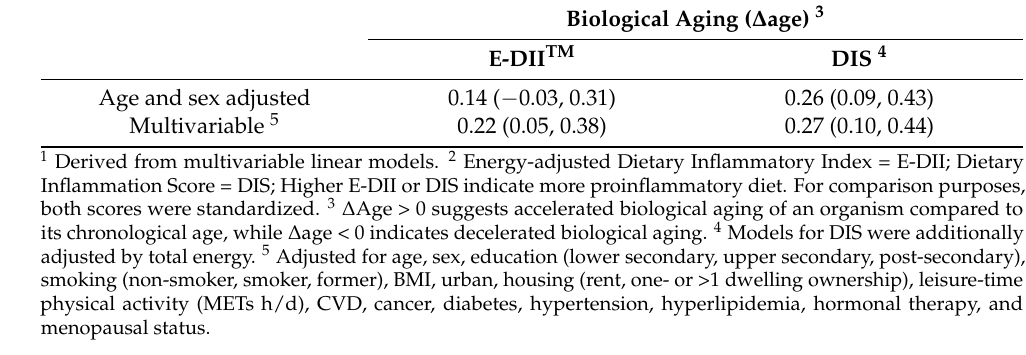
Table 3. Biological aging ( ∆ age) 1 by subgroup analyses according to E-DII and DIS 2 , in the Moli-sani sub-cohort (n =